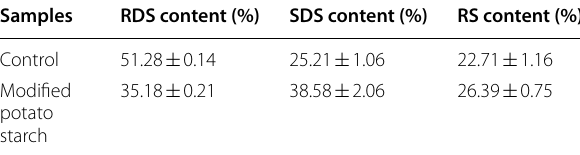
The data were expressed as means and standard deviations (SD), which were calculated from three repetitions of each